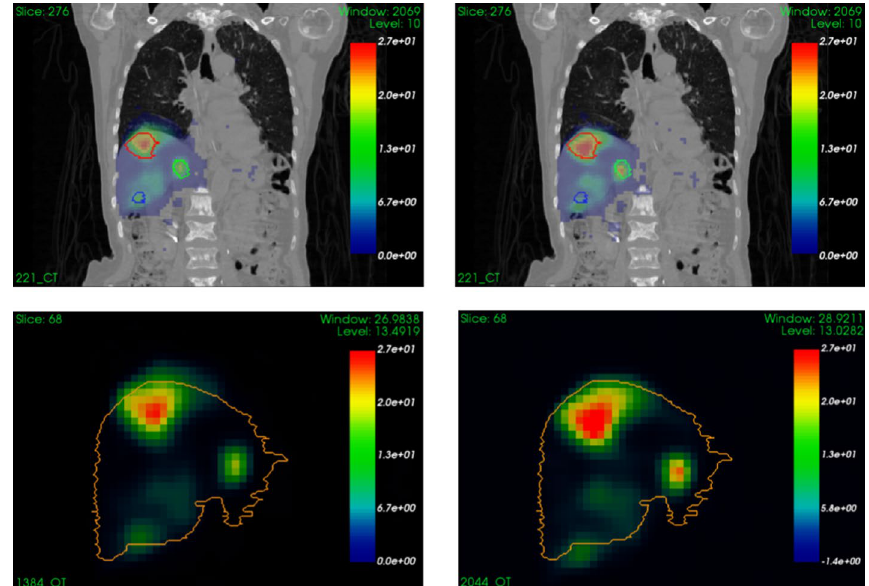
Fig. 1 3D (left) and 3Dcomp (right) reconstructions overlapped on CT (top) and reconstructions alone. Red, green and blue contours correspond to lesion contours initially drawn on the CT image. Orange contour is the mask of the liver